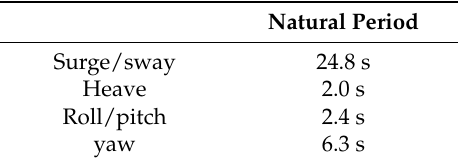
Table 7. Natural period for the SWMTF moored